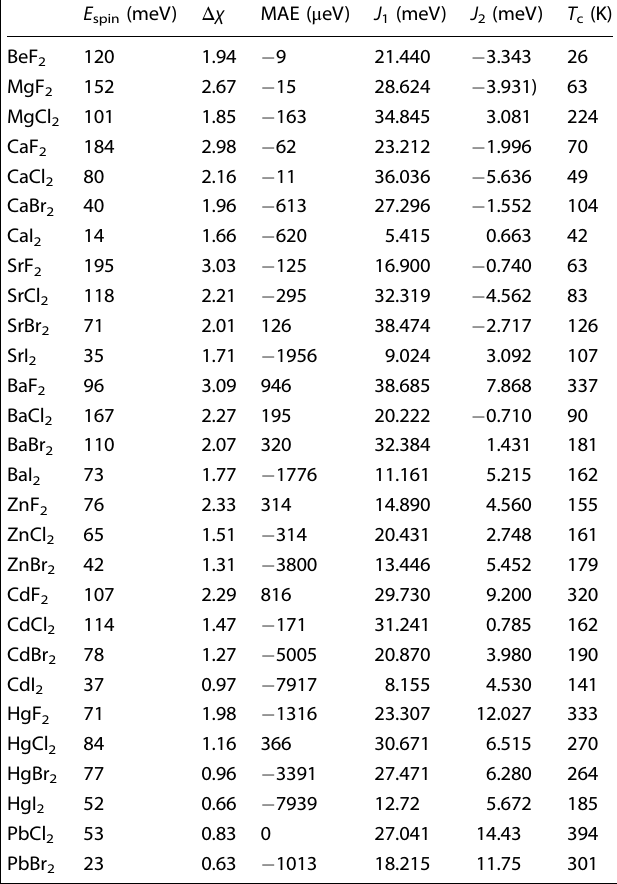
Table 1. Spin polarization energy E spin , electronegativity difference Δ χ , magnetic anisotropic energy MAE, nearest-neighbor exchange interaction parameter J 1 , next-nearest-neighbor exchange interaction parameter J 2 , and Curie temperature T c at hole doping density of 6 × 10 14 cm − 2 for the